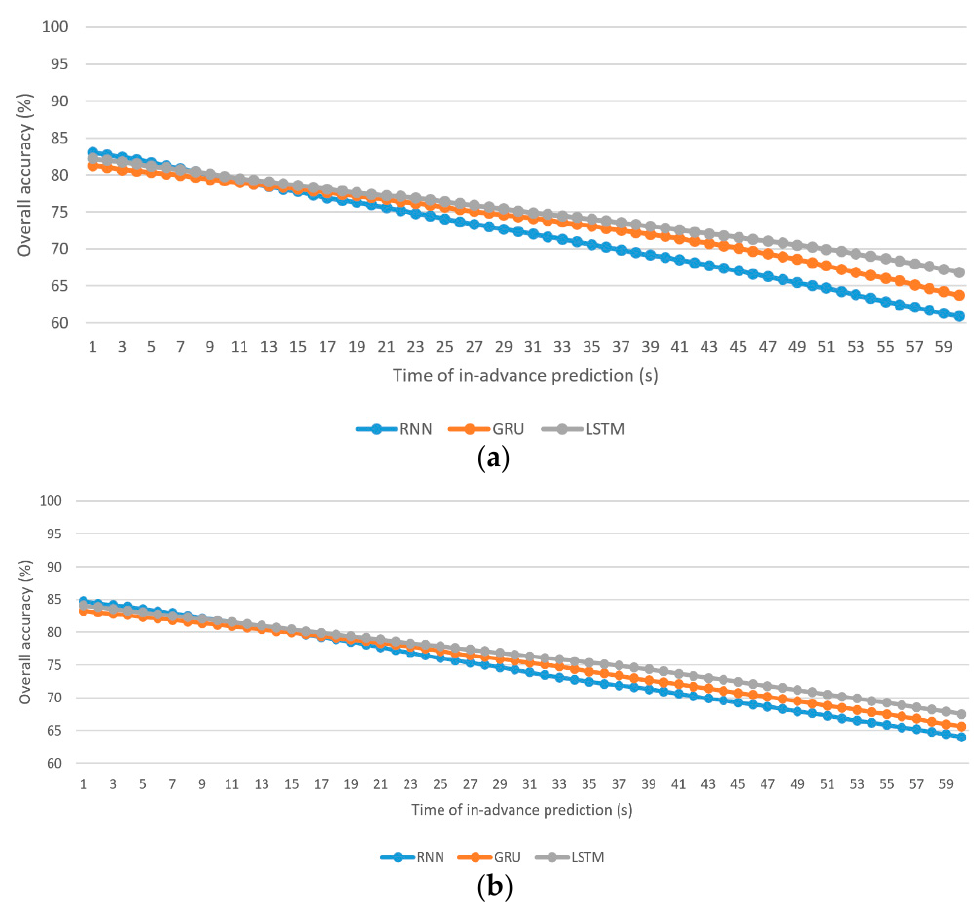
Figure 5. Overall accuracy of the prediction models based on individual RNN, GRU, and LSTM